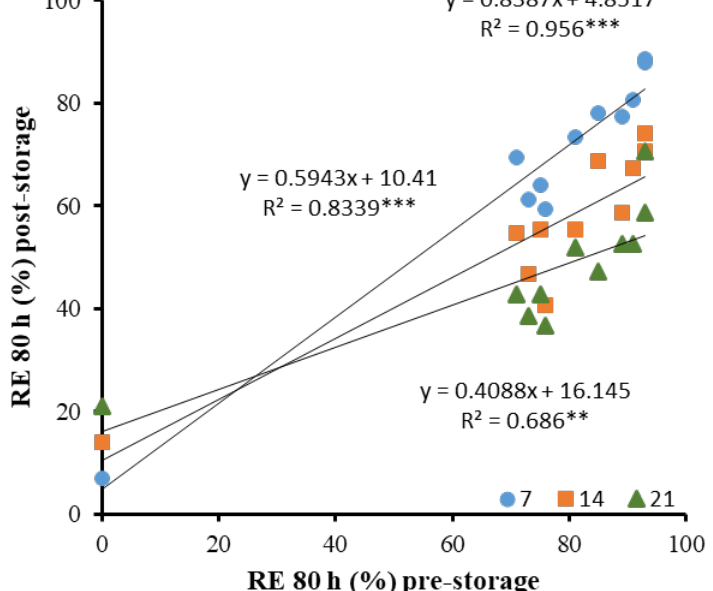
Figure 5. Correlation between RE 80 h counts of pre- and post-storage after 7, 14, and 21 days. Sig- nificance: **: 0.01, ***: 0.001.